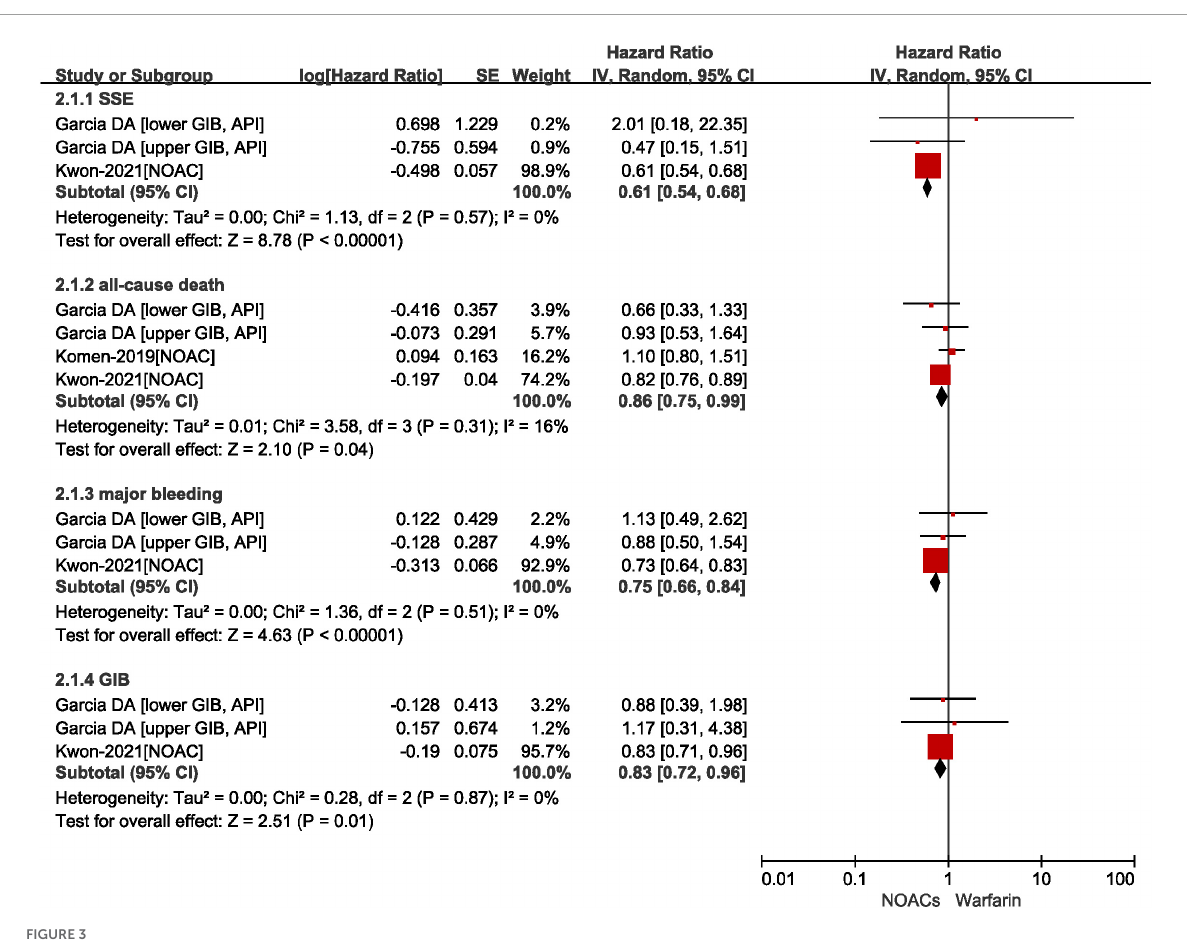
FIGURE3 Comparing the effect of NOACs with VKAs in AF patients with GIB. AF, atrial fibrillation; GIB, gastrointestinal bleeding; VKAs, vitamin K anticoagulants; NOAC, non-vitamin K antagonist oral anticoagulants; CI, confidence interval; IV, inverse of the variance; SE, standard error; SSE, stroke and systemic